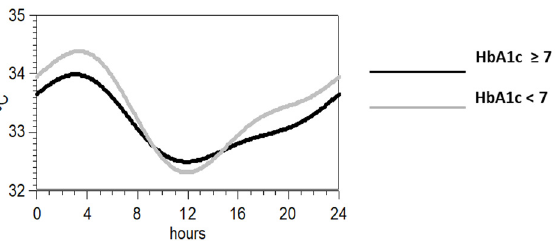
Figure 2. Synthesis of the mean waveform for wrist temperature according to a two-harmonic model of those individuals with HbA1c above (black) or below the mean (grey).